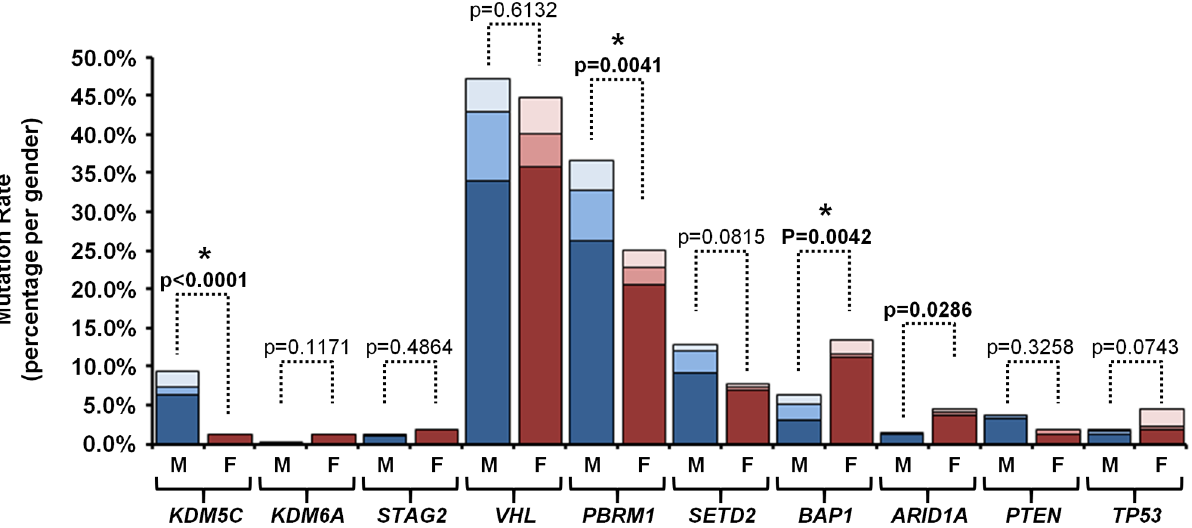
Fig 1. The Gender Specific Mutation Rate of 10 Commonly Mutated CCRCC Genes. The percentage of mutation for 10 genes commonly mutated in CCRCC genes were collated for 628 tumors from three large sequencing projects ( STAG2 data was only available from two projects) [2 – 4]. The difference in mutation frequency between genders was assessed by Fisher ’ s Exact tests. Bold text represents statistically significant differences before Bonferroni correction (p-value < 0.05) and * represents statistically significant differences after Bonferroni correction (p-value < 0.005). The expected percentage of mutations in male or female patients was calculated based on the overall mutation rate and the ratio of males to females. The blue bars represent the male patients with dark blue signifying the TCGA cohort, blue signifying the Sato et al cohort and light blue signifying the Guo et al cohort. The red bars represent the female patients with dark red signifying the TCGA cohort, red signifying the Sato et al cohort and light red signifying the Guo et al